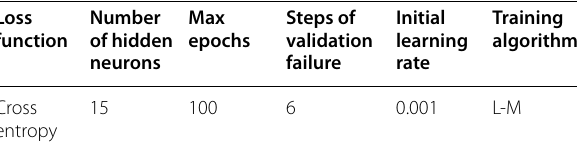
Table 5 Training parameters of the